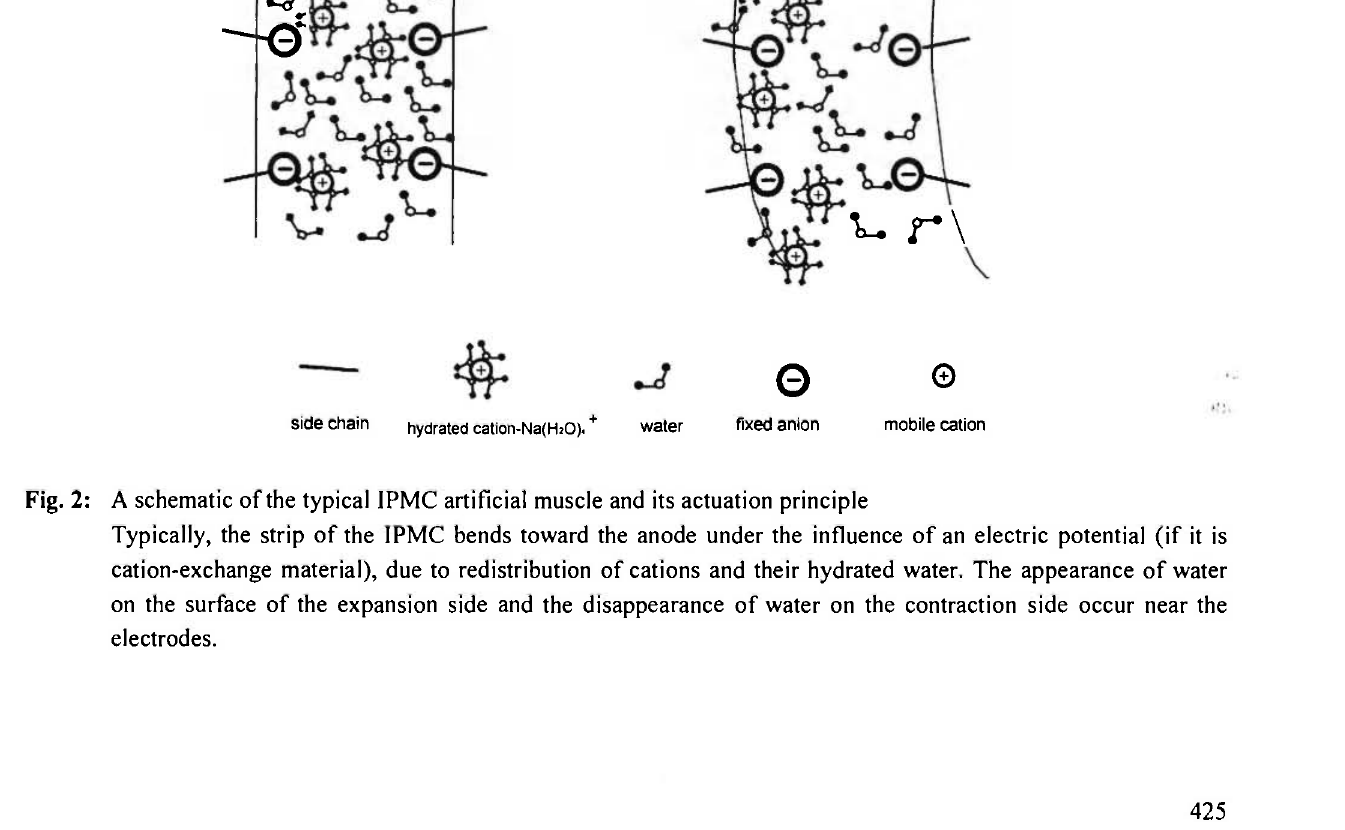
Fig. 1: An IPMC shape-changing structure under a time variable voltage signal of 2 volts